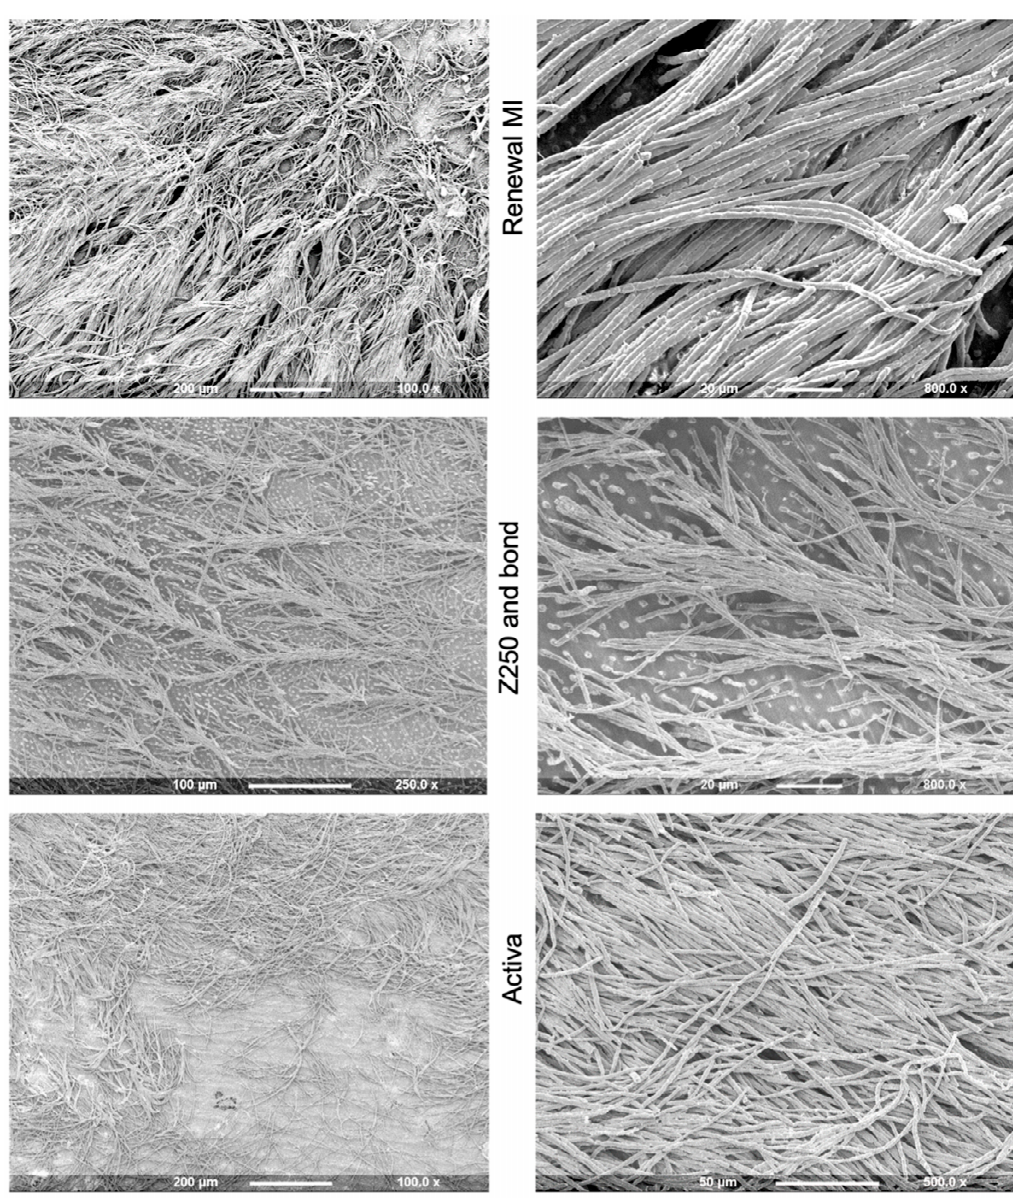
Figure 3. SEM images of resin tags formed within demineralized dentine by Renewal MI, Z250 and Activa (Fuji II LC and Fuji IX gave no tags).